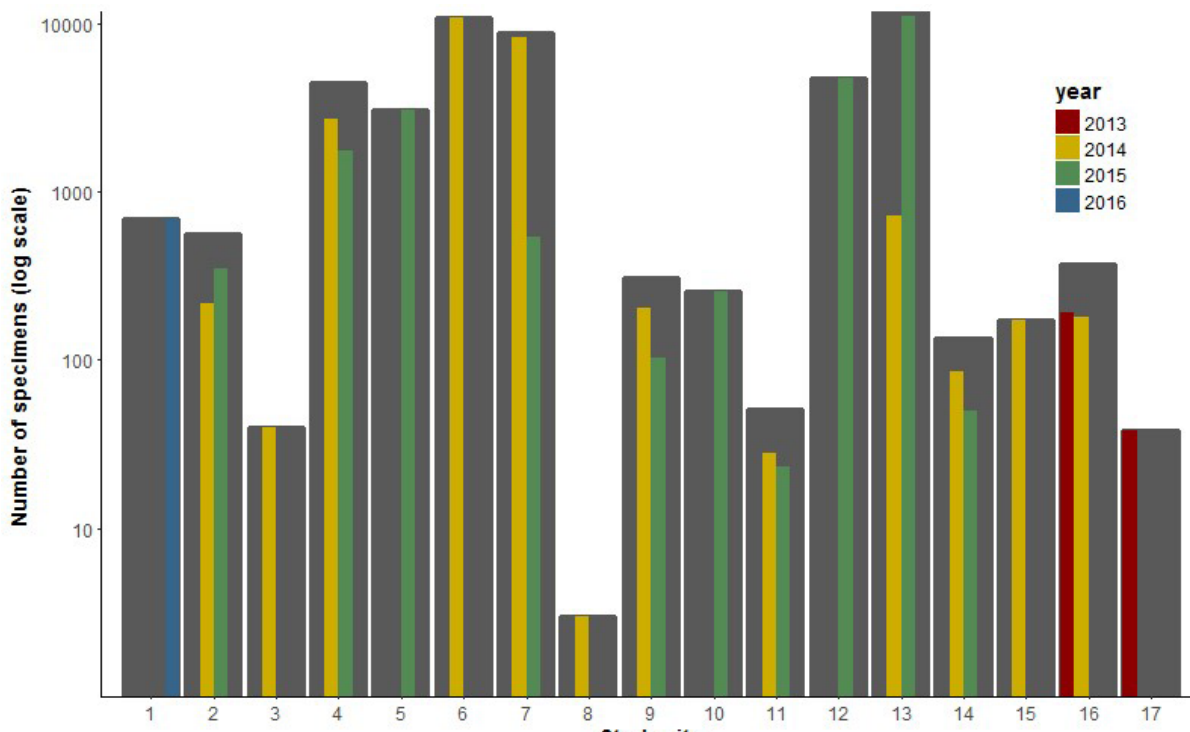
Figure 8. Total number of specimens in the dataset by study site (grey bars) and by sampling year (coloured bars). Study site codes correspond with those in the map of Figure